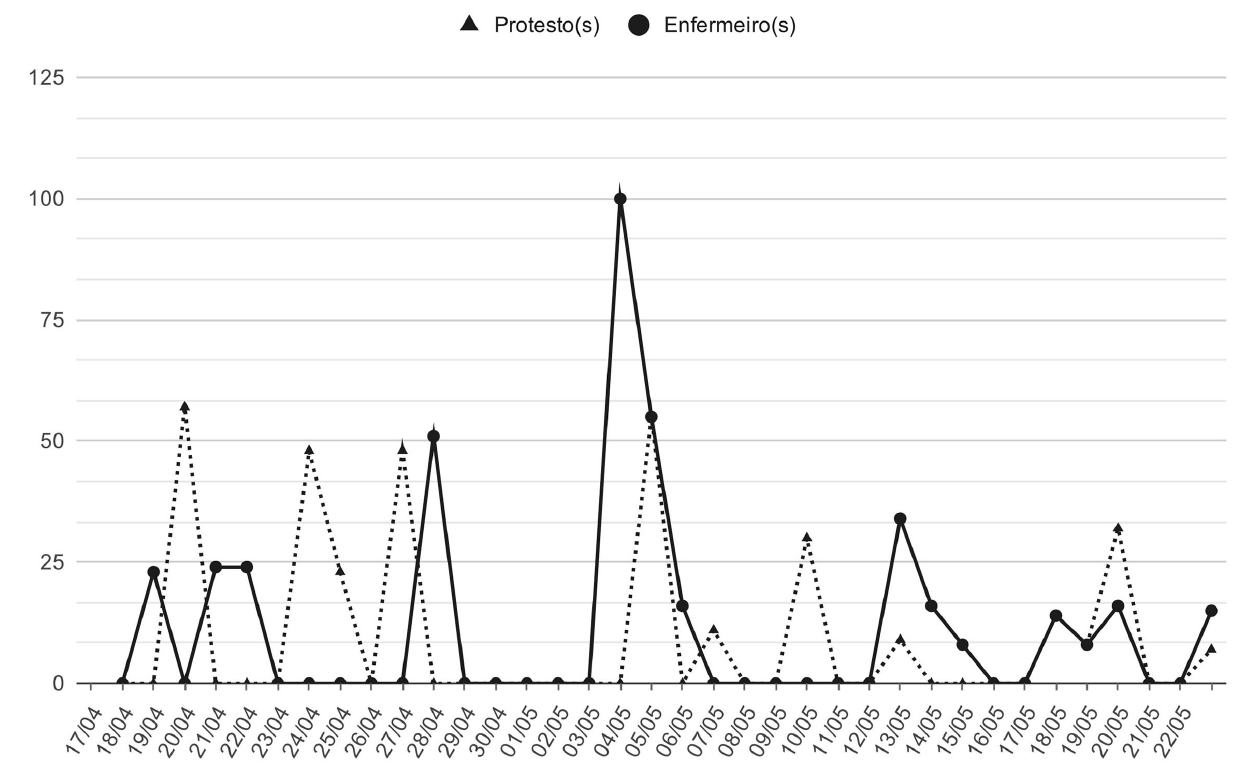
phrases such as “Nursing in mourning for professionals who are victims of the COVID-19” or “Stay at home.” The act also paid homage to the memory of the 55 nurses, technicians, and assistants who had already lost their lives on the front lines due to